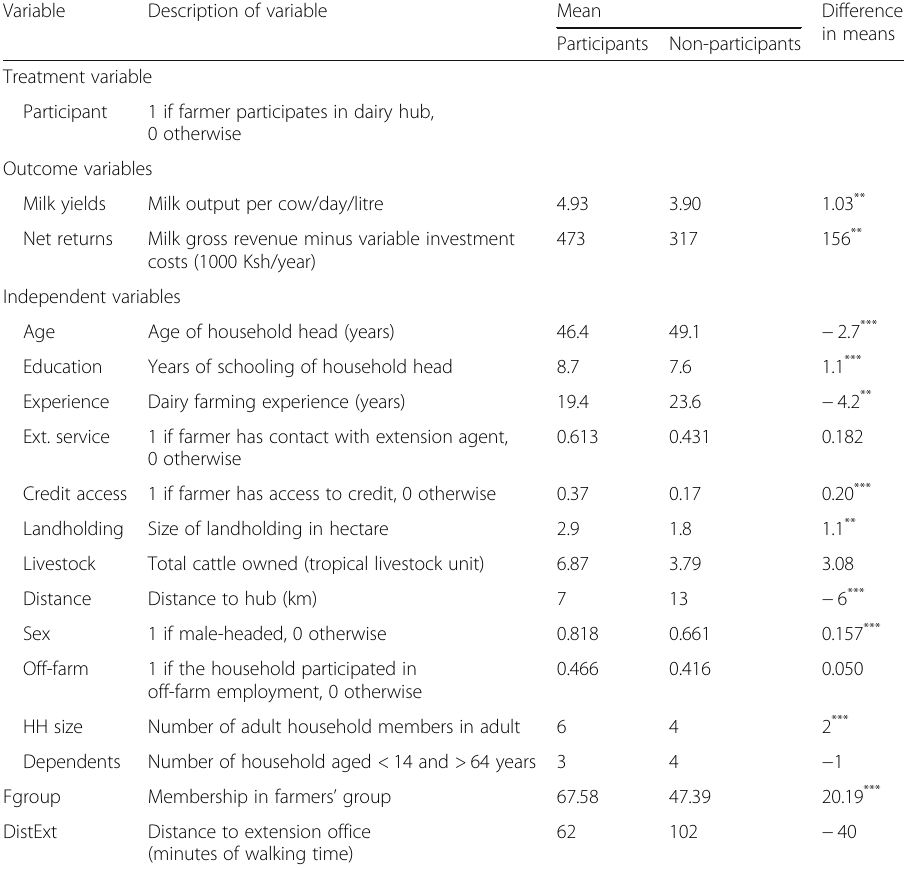
Table 1 Descriptive statistics of selected variables for participants and non-participants Variable Description of variable Mean Difference Treatment